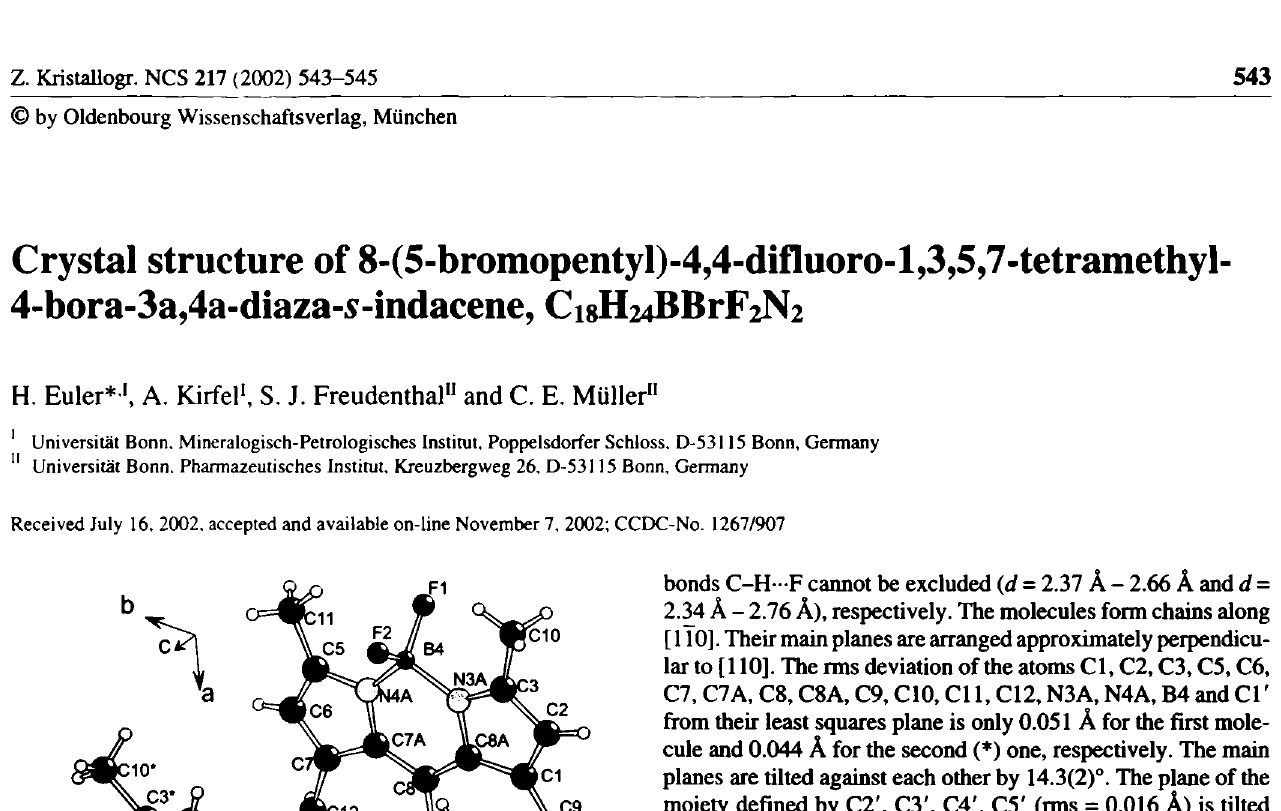
Table 1. Data collection and handling.